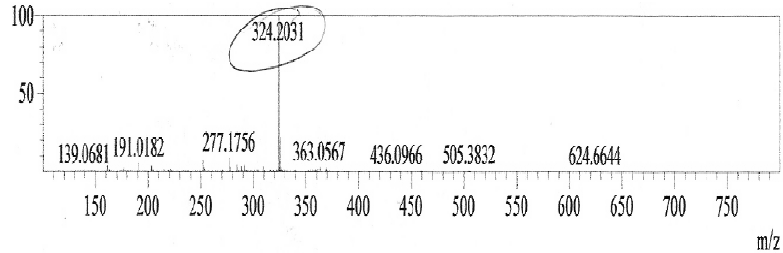
Figure 5. Mass spectrum of the purified red pigment produced by S. marcescens UCP